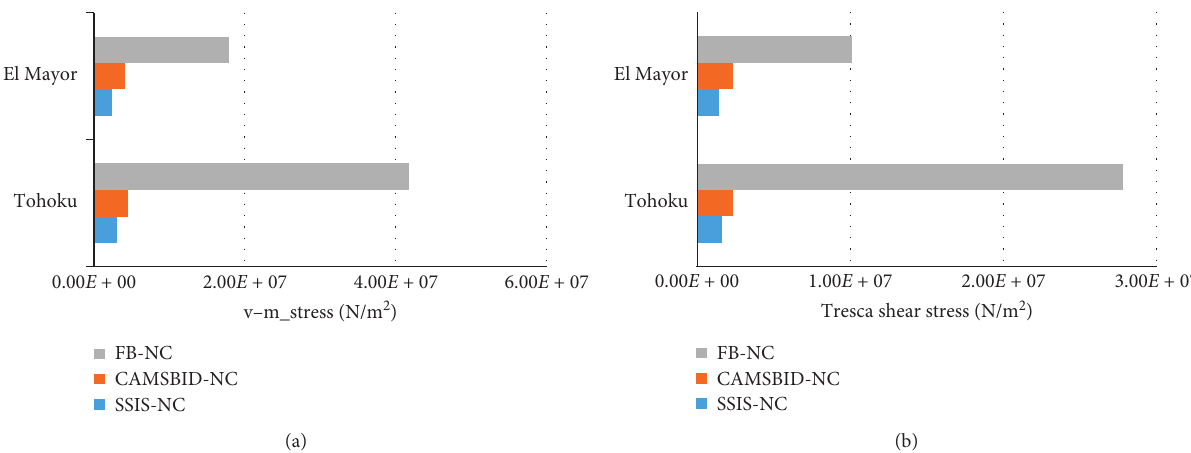
Figure 18: Comparison of peak (a) effective stress (Von-Mises) and (b) critical shear stress (Tresca) responses of the SSIS-NC, CAMSBID- NC, and FB-NC